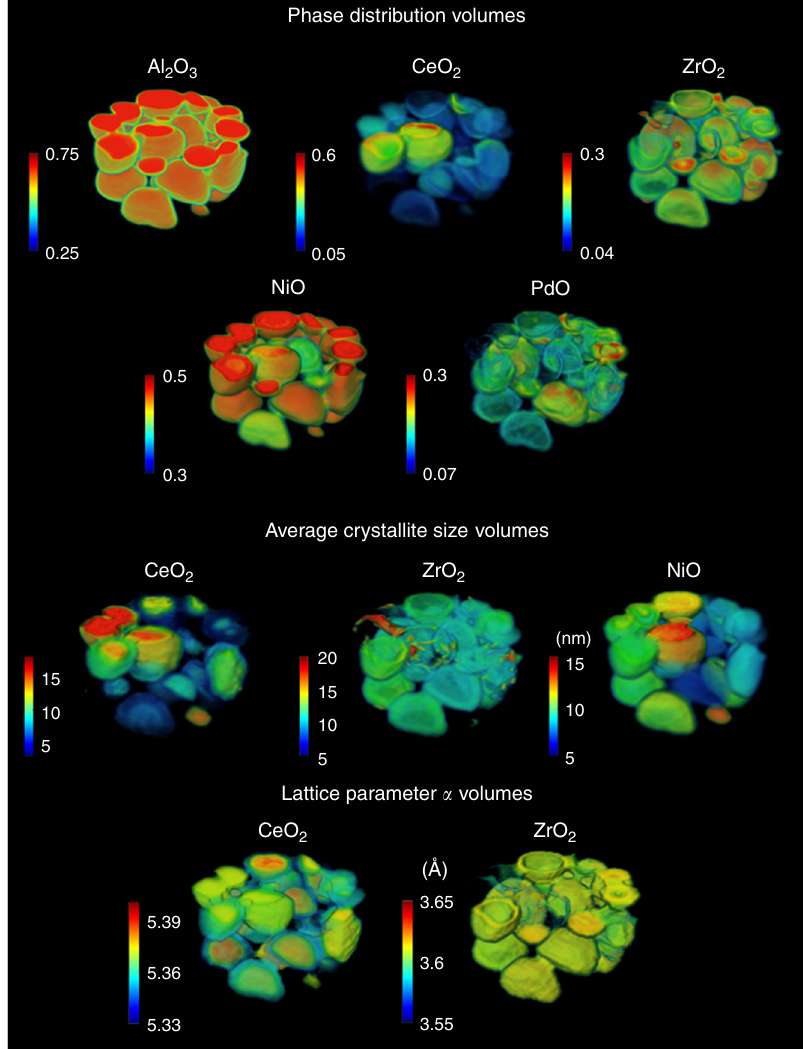
Fig. 2 3D maps obtained from the Rietveld analysis of the 3D-XRD-CT data collected at room temperature. Top: volume rendering of the normalised scale factors (phase distribution volumes). The values in the colorbar axes have been chosen to achieve the best possible contrast. Middle: volume rendering of the average crystallite size maps of CeO 2 , ZrO 2 and NiO (colorbar axes in nm). Bottom: volume rendering of the lattice parameter a of CeO 2 and ZrO 2 unit cells (colorbar axes in